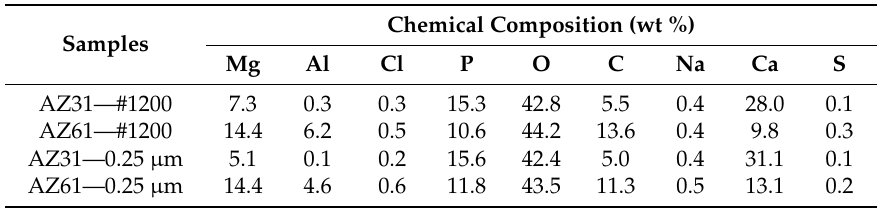
Table 6. Chemical composition of corrosion product on the surface of AZ31 and AZ61 magnesium alloys after EIS measurements in enriched HBSS+ (with Mg 2+ and Ca 2+ ions).